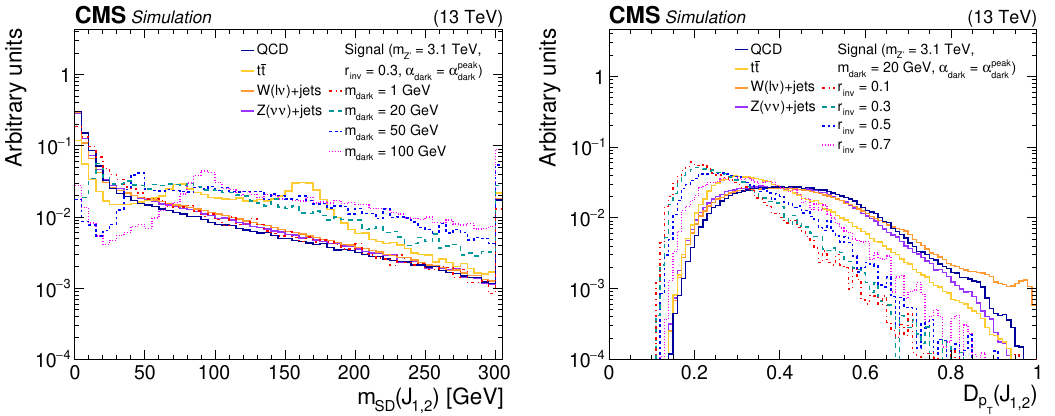
and D for the two SD p T T